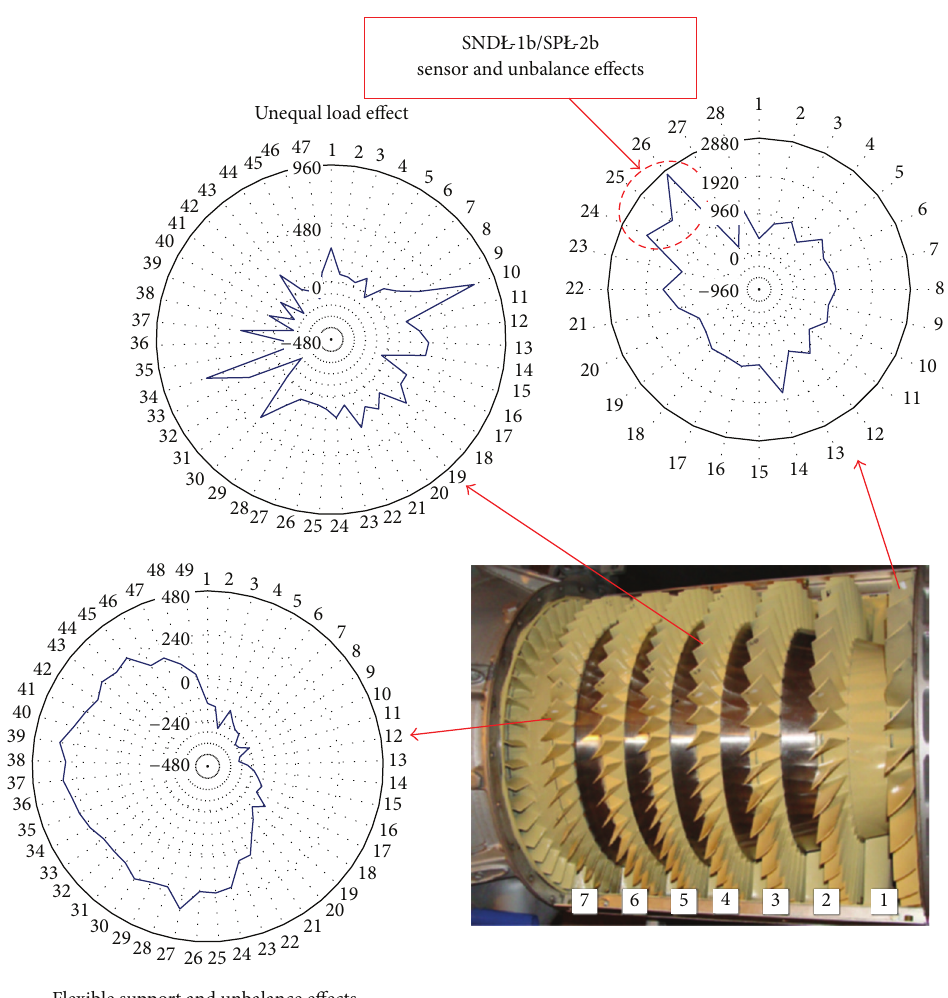
Figure 24: Detection of stress prehistory (irreversible process of stress magnetization) and identification of blade fatigue risk [3, 22].